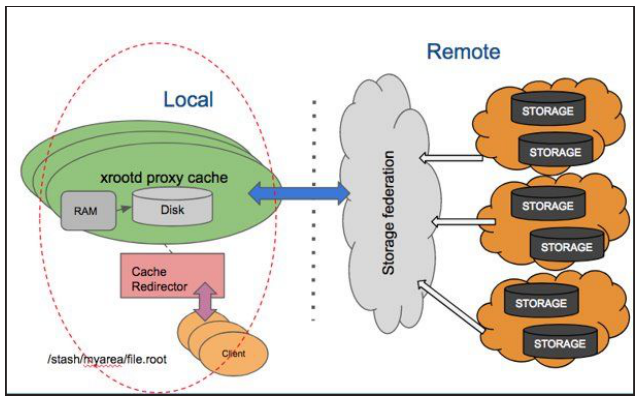
Fig. 4. Data Cache architectural schema. The AAA federation of CMS (right) and the dynamic cache system (left) are